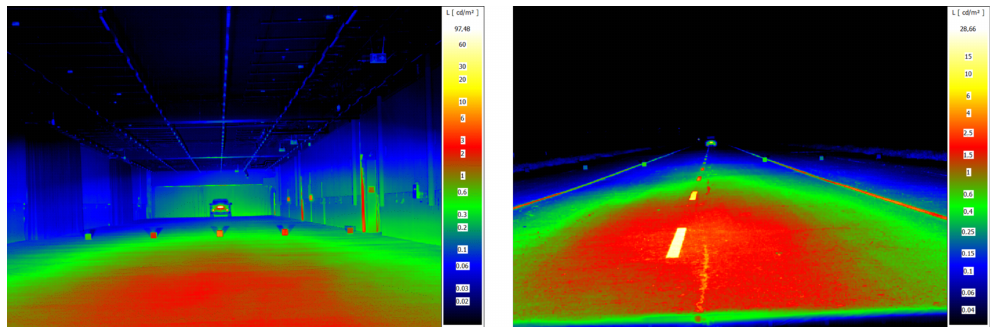
Figure 7. Exemplary representation of the recorded luminance images for the light tunnel ( left ) and the closed test site ( right ); the fixation vehicle, which is positioned behind the last row of objects in the driving direction, can be observed in both